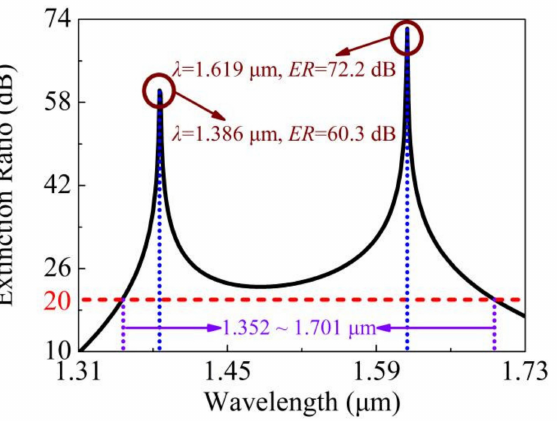
Figure 14. The relationship of the ER in the core A of the proposed LC-DC-PCF with wavelengths.